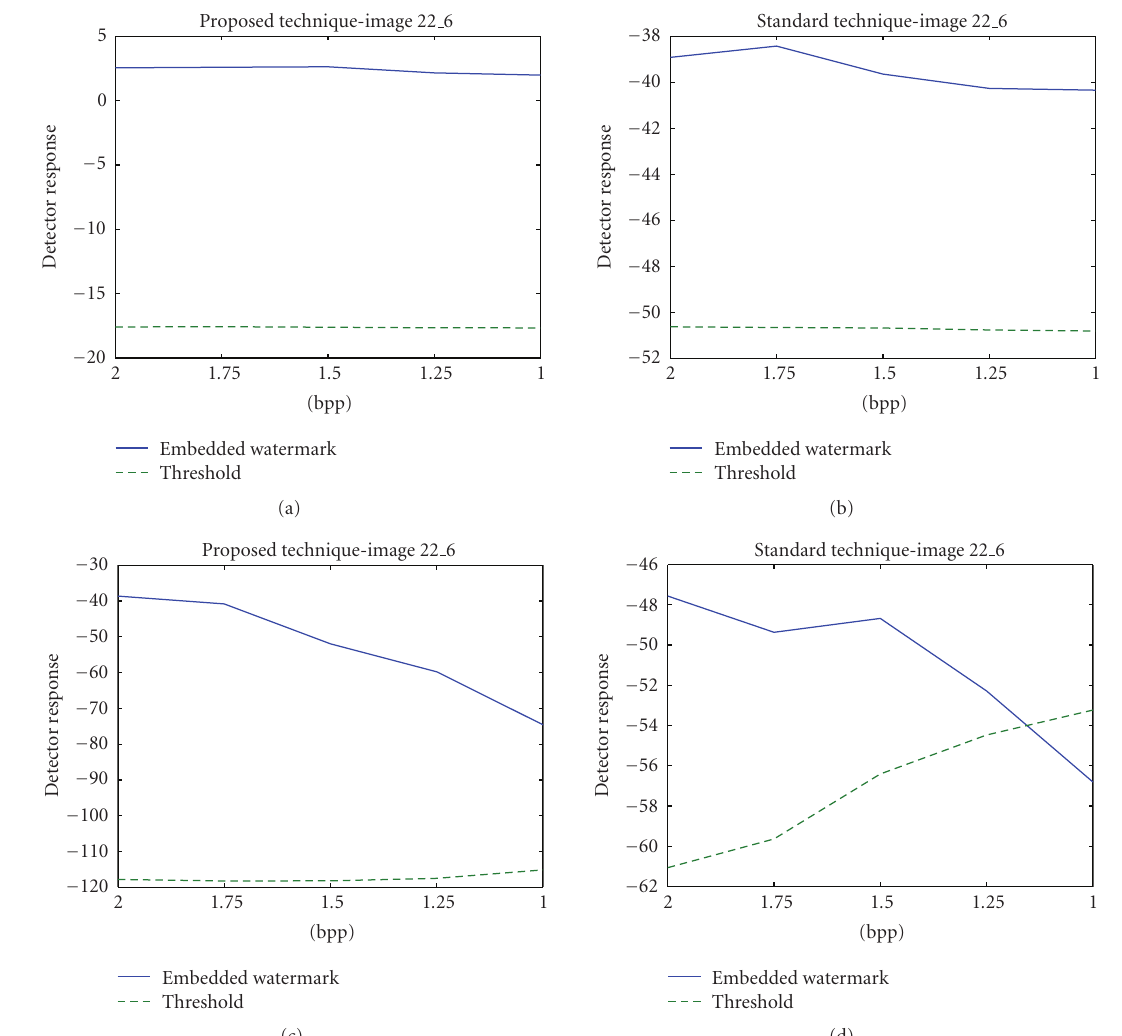
Figure 11: Robustness against WSQ compression. Top: DWT domain. Bottom: DFT domain. Left side graphs: Proposed technique. Right side graphs: Standard